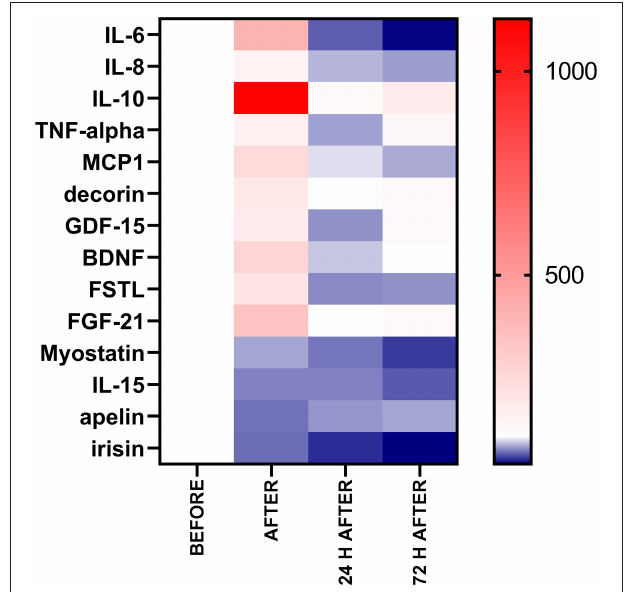
FIGURE 9 | Percentage of baseline value of the exercise-induced cytokines after, 24h after, and 72h after. The values are presented as percentage of baseline value (before) compared with after, 24h after, and 72h after the race of 38–54 runners. Colormap with range between 1,129 and 37% and red for the largest value, white for the baseline (100%) and blue for the smallest